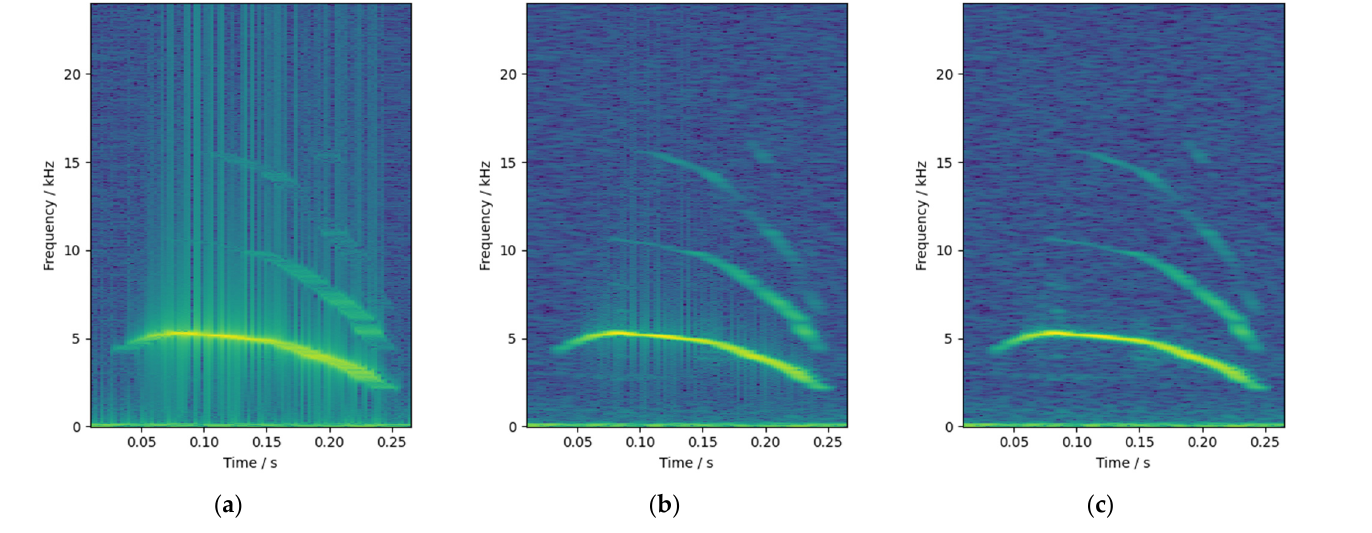
Figure 6. Spectrogram comparison: ( a ) without window; ( b ) Hamming window; and ( c ) Hanning